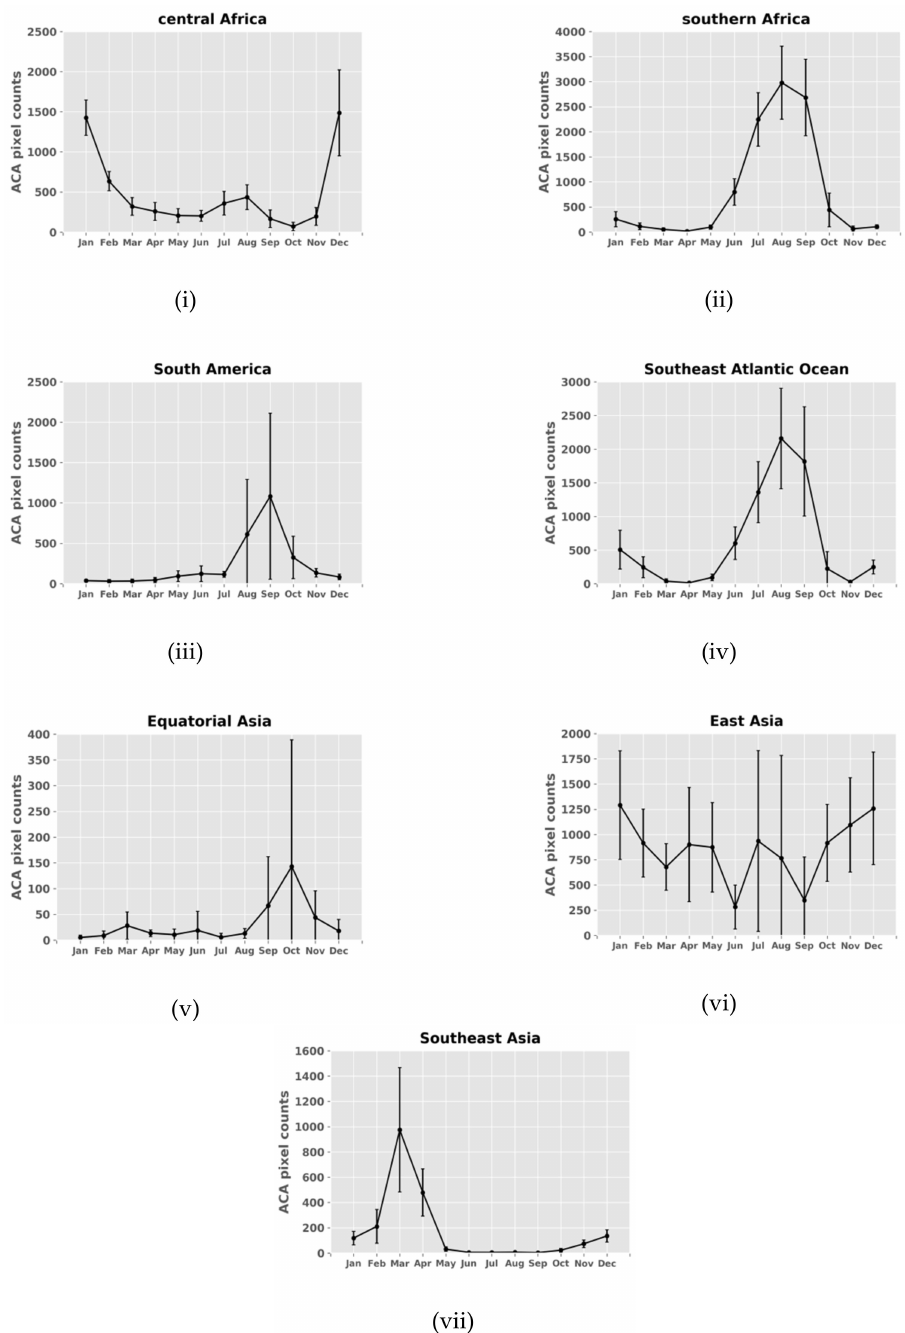
Figure 5. Intra-annual variability of the 2005–2015 averages of the regional total absolute number of grid cells (1 ◦ × 1 ◦ ) where absorbing carbonaceous aerosols (ACA) have been detected by the satellite algorithm (left column). Results are presented for: ( i ) Central Africa, ( ii ) Southern Africa, ( iii ) South America, ( iv ) Southeast Atlantic Ocean, ( v ) Equatorial Asia, ( vi ) East Asia and ( vii ) Southeast Asia. Error bars represent the year-by-year variability by means of computed 2005–2015 standard